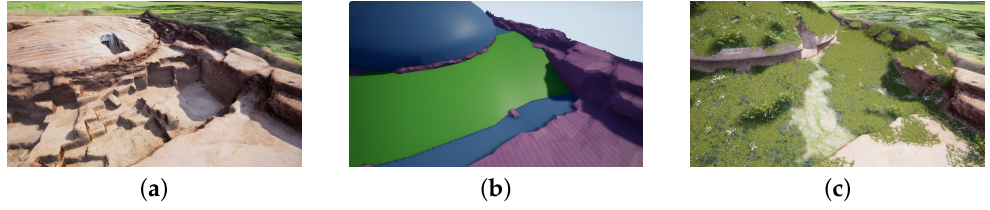
Figure 7. Digital Replica (DR, a ), Proxy model ( b ) and Representation Model (RM, c ) related to the mound 2471 of the Onde Marine site. See colour chart in Table